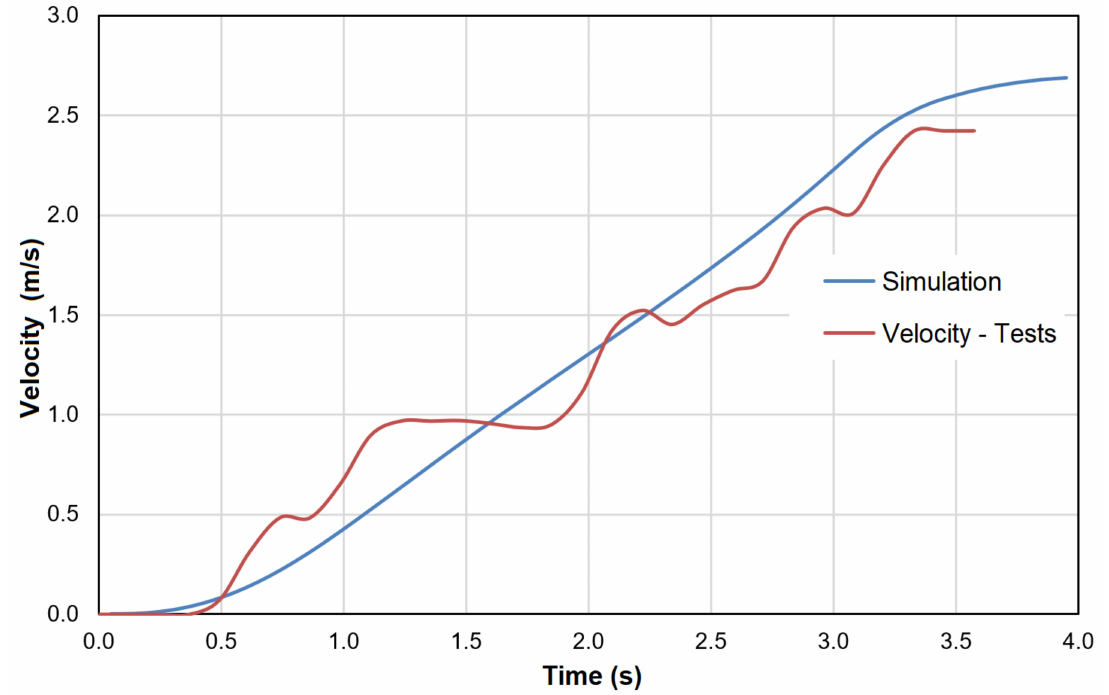
Figure 16. Comparison of velocity measurement results, and analysis of the results for the value of the working stroke s = 6.5 mm.